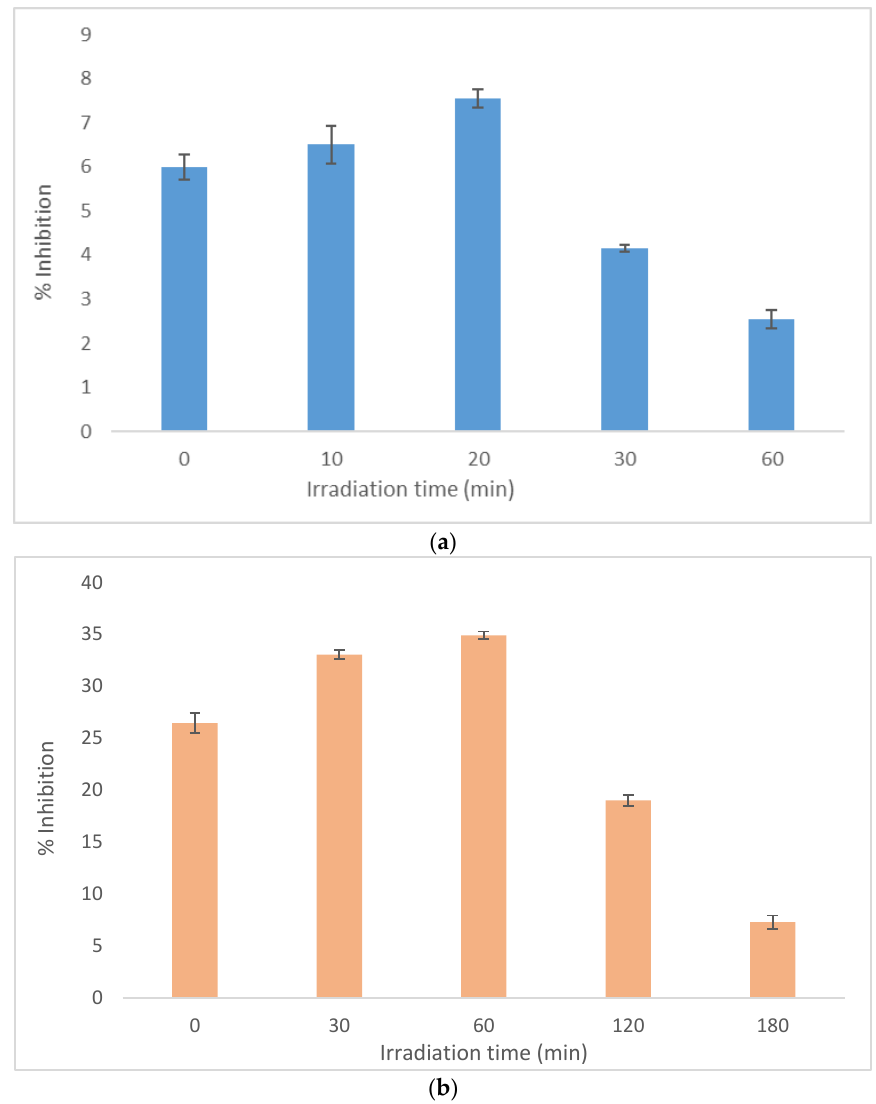
Figure 6. Evolution of toxicity during the photocatalytic process in: ( a ) UW; and ( b ) WW using Chlorococcum sp. ([amisulpride] 0 = 1 mg L −1 ; [g-C 3 N 4 ] = 300 mg L −1 ).